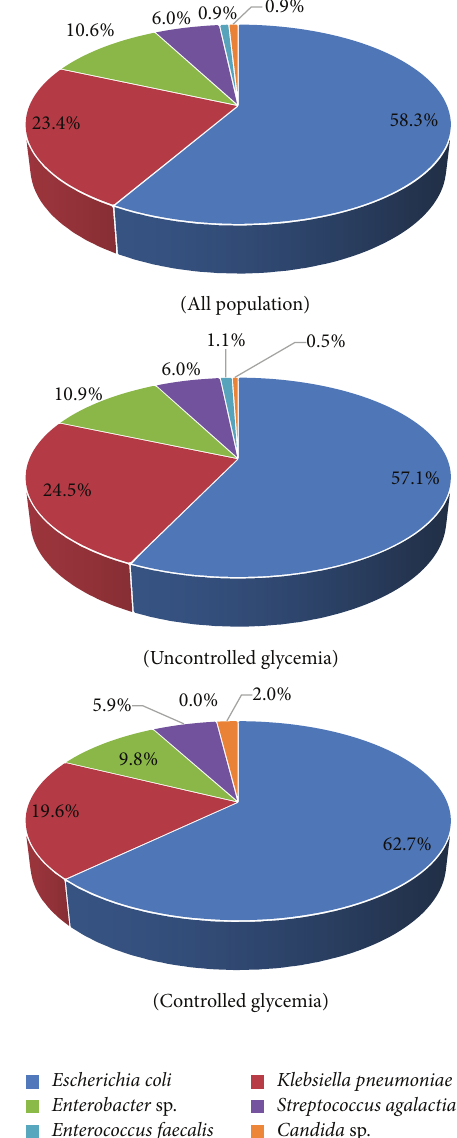
Figure 2: Distribution of most UTI prevalent pathogens in our study population